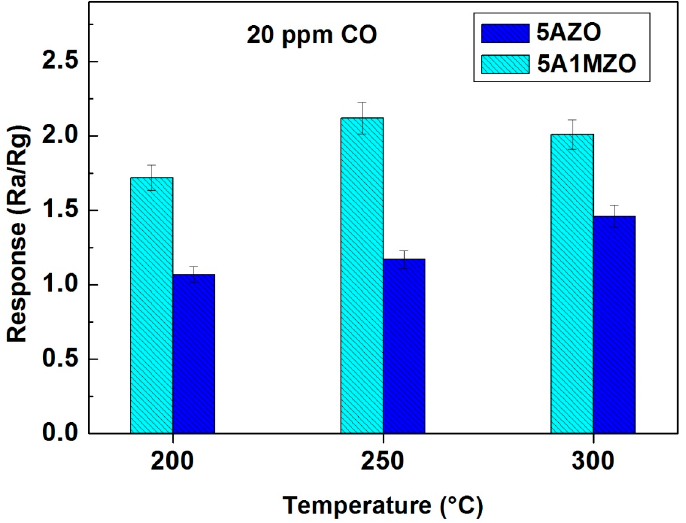
Figure 11. Responses of the 5AZO and 5A1MZO based sensors to 20 ppm CO versus operating temperatures.